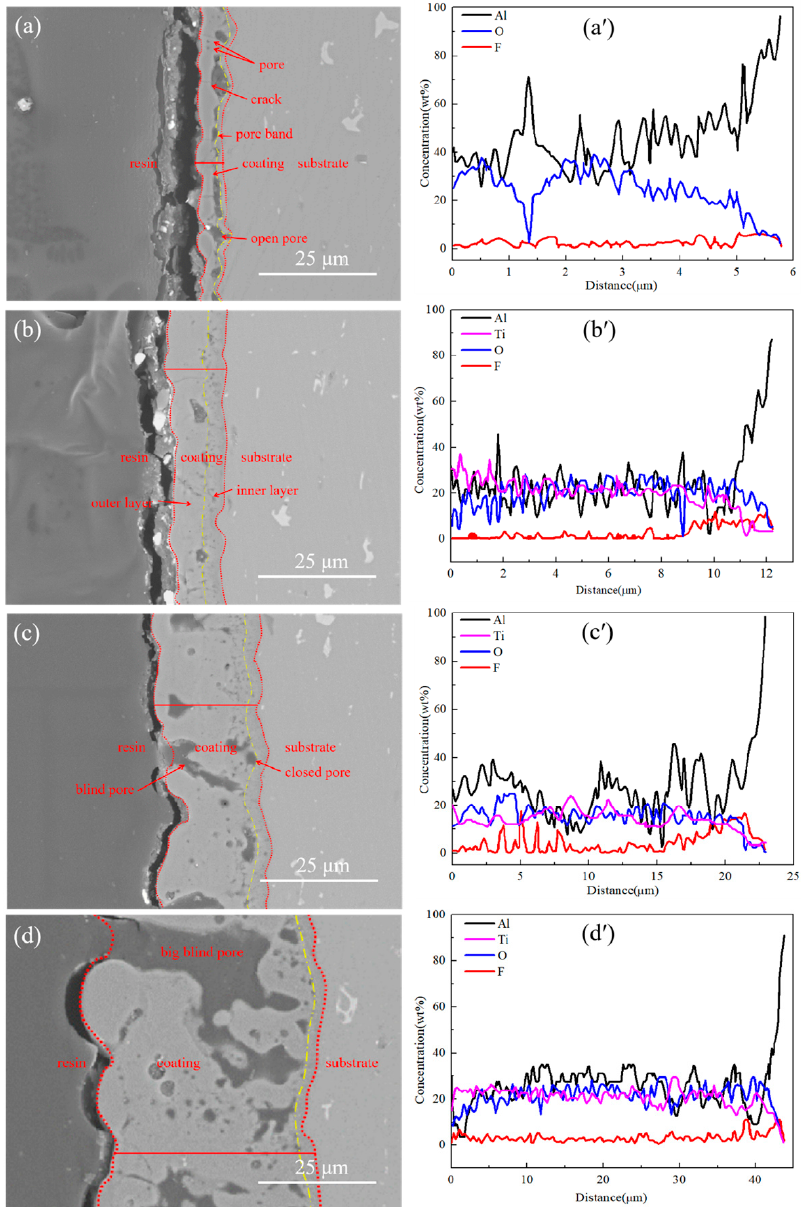
Figure 4. Cross ‐ sectional morphology of MAO films after micro ‐ arc oxidation for 10 min and the elements Figure 4. Cross-sectional morphology of MAO films after micro-arc oxidation for 10 min and the line distribution examined by EDS: ( a , a ’) Ti0 ‐ 15, ( b , b ’) Ti5 ‐ 15, ( c , c ’) Ti5 ‐ 25 and ( d , d ’) Ti5 ‐ 35. elements line distribution examined by EDS: ( a , a ’) Ti0-15, ( b , b ’) Ti5-15, ( c , c ’) Ti5-25 and ( d , d ’)